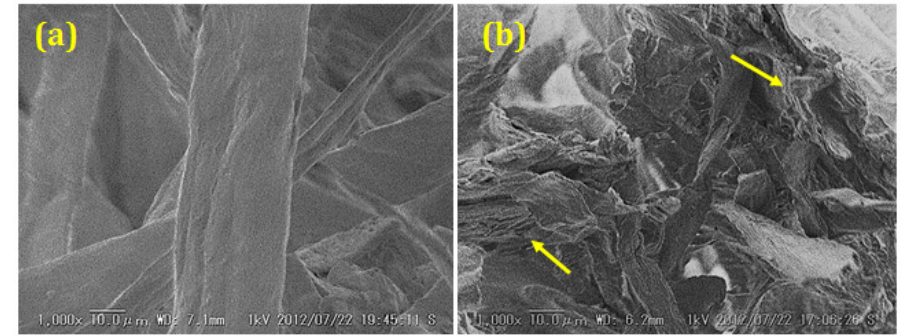
Figure 6. Scanning electron microscope (SEM) photography of cellulose and its biochar; ( a ) Raw cellulose; ( b ) HTC at 220 °C.